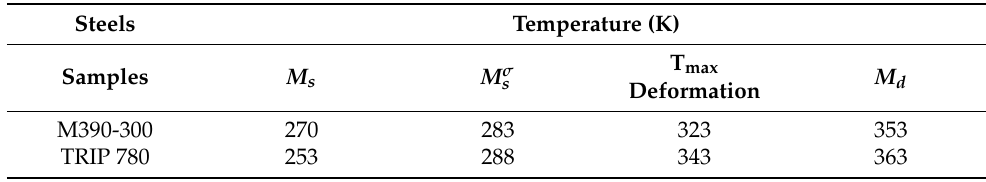
Table 7. Critical temperatures computed for retained